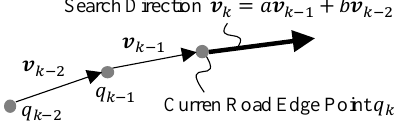
Figure 8. Search direction. Where 𝑎 and 𝑏 are weight parameters of previous search